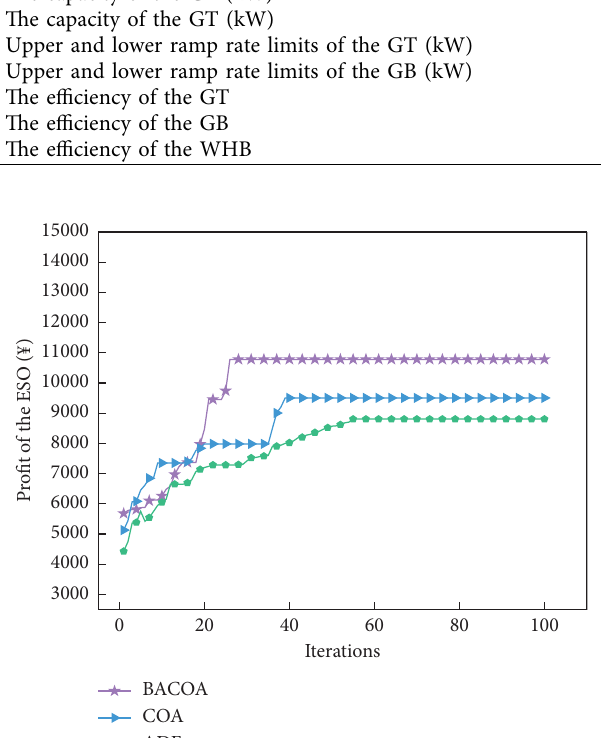
Figure 7: Te comparison of convergence curves of diferent algorithms.